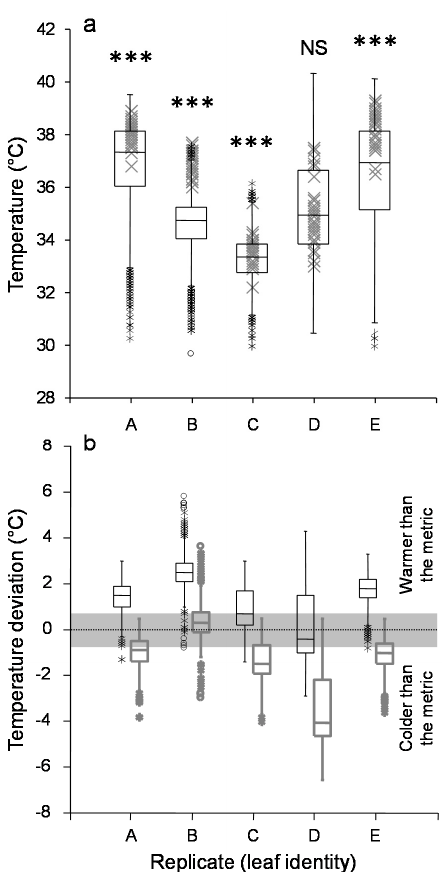
Figure 4. Aphid position within the leaf thermal pattern. ( a ) Overlap of the distribution of the whole leaf surface temperatures (box plot in black) and the distribution of temperatures at the position of the aphids (grey crosses) for the five replicates in the treatment with aphids on the surface of leaves. Asterisks and NS indicate a high level of significance ( p < 0.01) and non-significance, respectively, of the difference between the two distributions for each replicate. ( b ) Deviation between the surface temperature at the position of aphids and the mean leaf surface (black box plots) or the maximal leaf surface (grey box plots) temperature distributions. The grey zone illustrates the 0.9 confidence interval beyond which a distribution is deemed to differ from a distribution centered on zero. In each box, the central mark shows the median, and the bottom and top edges (called hinges) of the box indicate the 25th and 75th percentiles, respectively. The whiskers show the range of observed values that fall within the inner fences. Values between the inner and outer fences are plotted with asterisks (outside values). Values beyond the outer fences, called far outside values, are plotted with empty circles. The fences are defined relative to the range between the two hinges (called Hpsread): Lower inner fence = lower hinge − (1.5 × (Hspread)); Upper inner fence = upper hinge + (1.5 × (Hspread)); Lower outer fence = lower hinge − (3 × (Hspread)); Upper outer fence = upper hinge + (3 × (Hspread)).